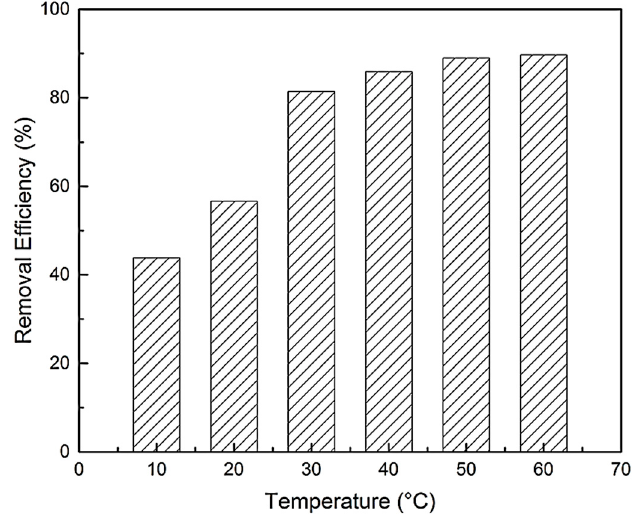
Figure 12. E ff ect of temperature on removal e ffi ciency (experimental conditions: adsorbent Figure 12. Effect of temperature on removal efficiency (experimental conditions: adsorbent dose = 7.0 dose = 7.0 g / L, initial concentration = 10 mg / L, contact time = 48 h, pH = g/L, initial concentration = 10 mg/L, contact time = 48 h, pH = 6.0).